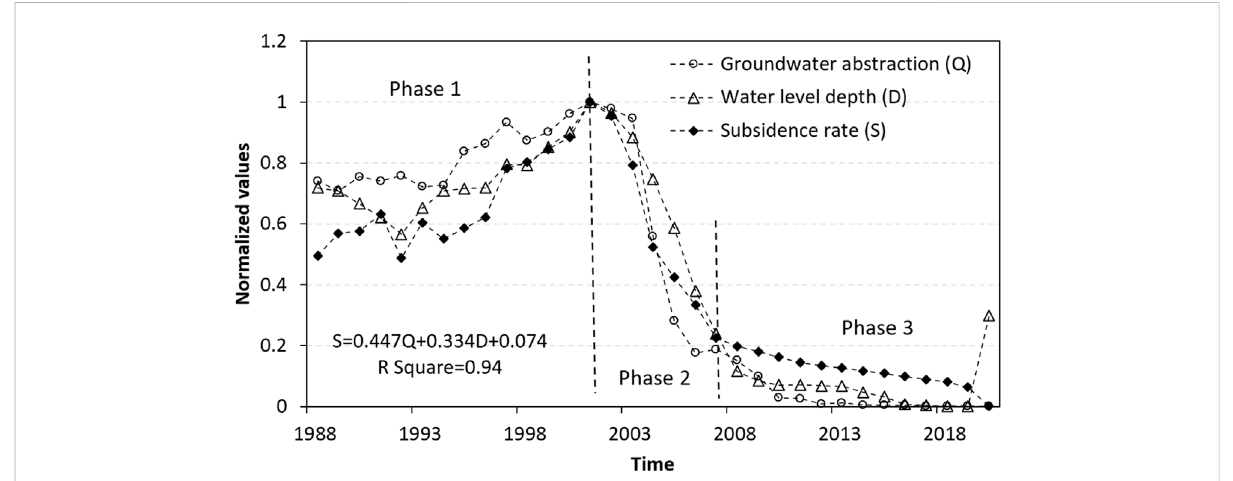
FIGURE 6 Temporal variation of groundwater abstraction and the water-level depth and subsidence rate of the subsidence center in the central urban area of Cangzhou City (All the values are